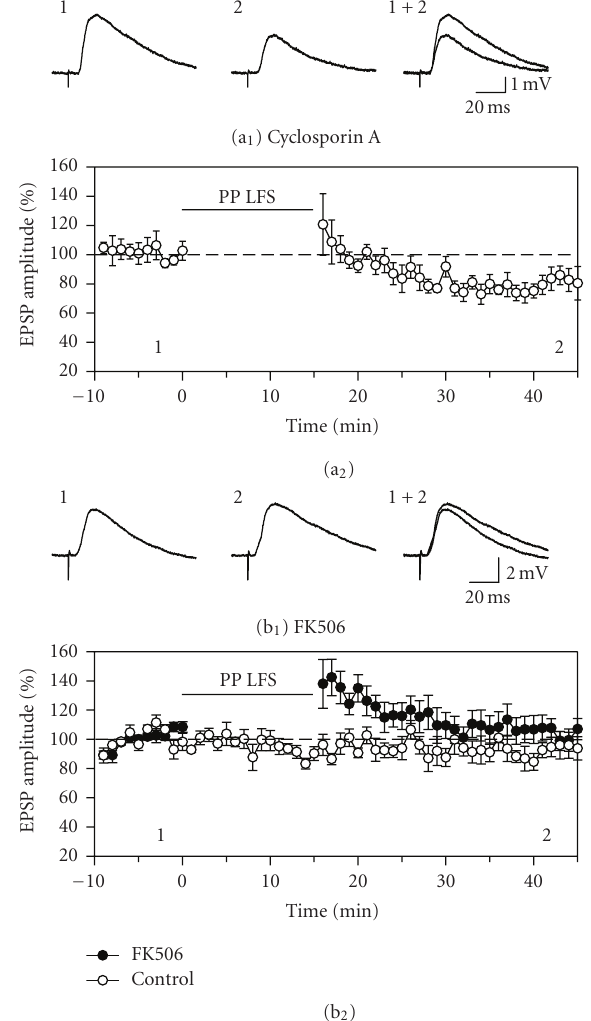
Figure 3: Long-term depression is dependent on activation of the calmodulin-dependent protein phosphatase calcineurin. Although LTD was only partially inhibited by pre-exposure to cyclosporin A, it was completely blocked when FK506 was included in the recording electrode solution. (a) Pre-exposure of slices to the calcineurin inhibitor cyclosporin A (250 μ M) for 1.5 to 3 hours resulted in a partial block of LTD by repeated paired- pulse stimulation. The amount of LTD induced was smaller than in control ACSF and was close to statistical significance ( n = 6, P = . 07). (b) Including the FK506 in the recording electrode solution to directly block postsynaptic calcineurin prevented the induction of LTD. Analysis of group responses showed a significant increase in responses during the baseline period, but responses in control cells indicate that this increase is transient and unlikely to have a ff ected measurement of LTD. Inhibition of postsynaptic calcineurin therefore prevents induction of LTD in layer II cells of the entorhinal cortex.